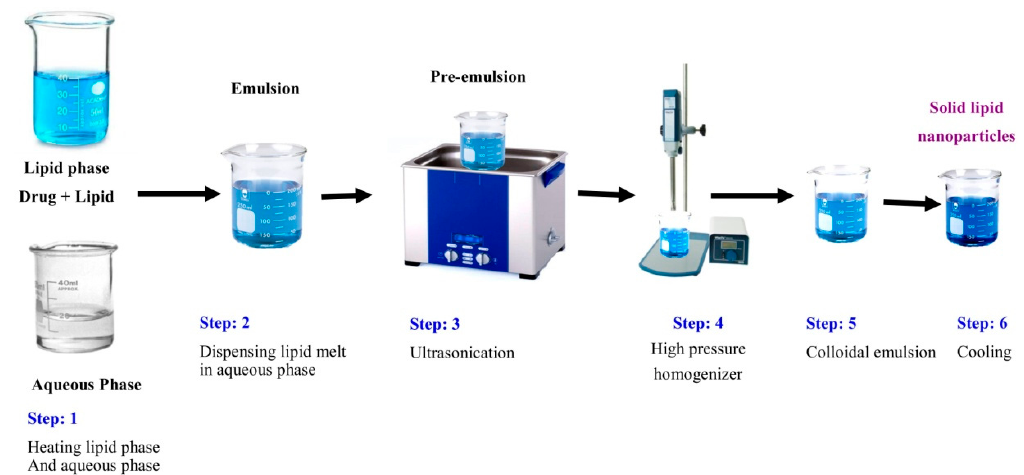
Figure 2. Step by step procedure of hot homogenization technique.